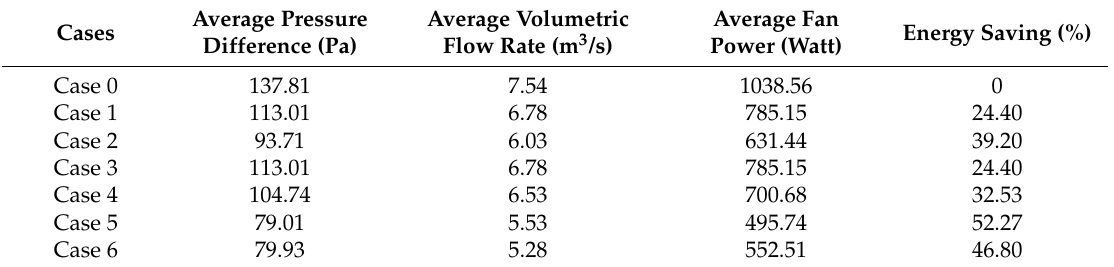
Table 3. Energy saving for various ventilation patterns in 1800 s.